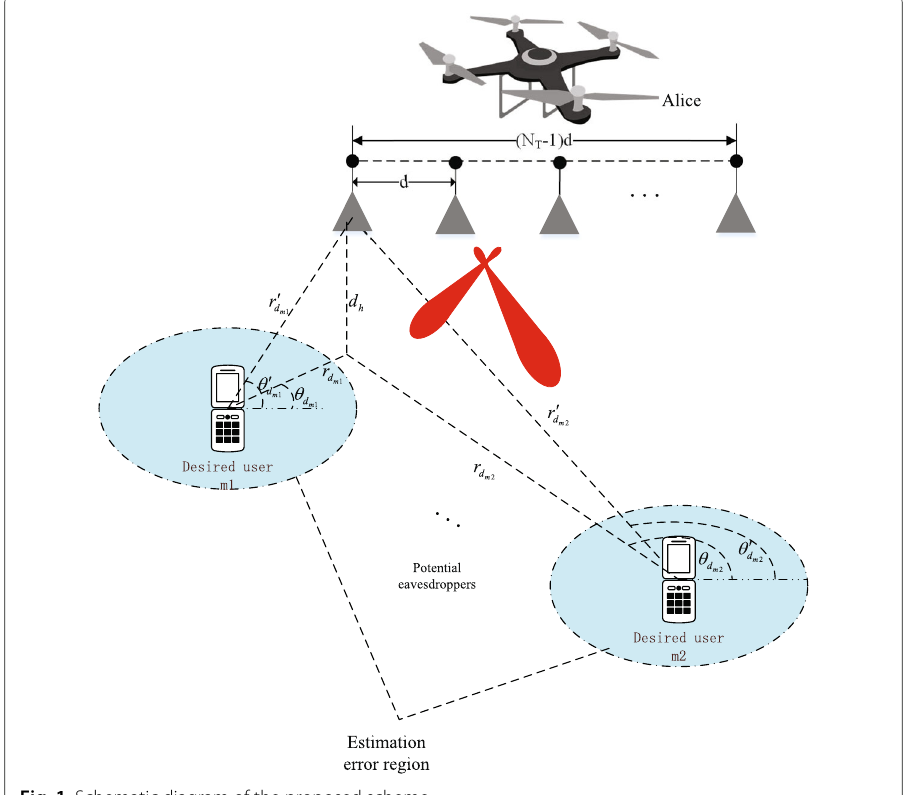
Fig. 1 Schematic diagram of the proposed